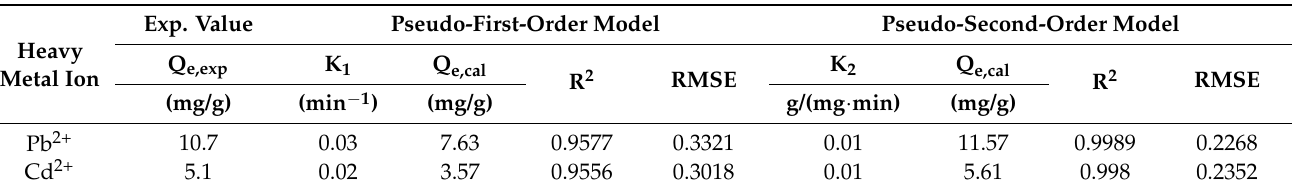
Figure 12. Cd adsorption kinetic model fitting: ( a ) pseudo-first-order model; ( b ) pseudo-second-order model. Table 7. Fitting parameters of adsorption kinetic